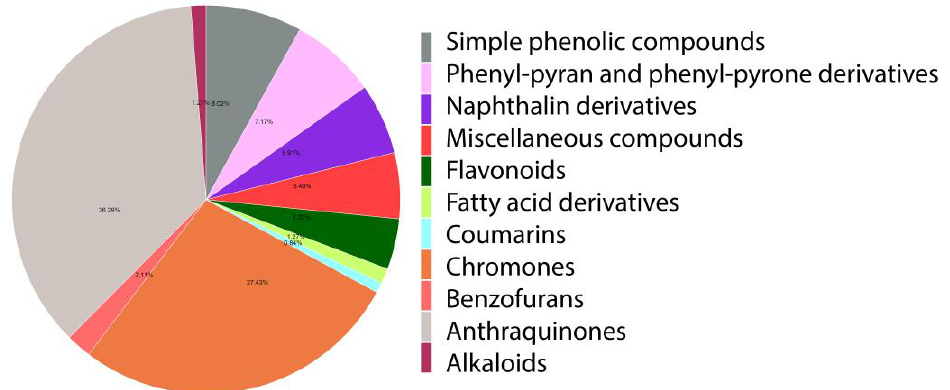
Figure 1. The percentage of different classes of phytochemicals reported from the genus Aloe . An- thraquinones 36.3%, chromones 27.4%, coumarin 0.8%, flavonoids 4.2%, simple phenolic compounds 8%, phenyl pyran and phenyl pyrone derivatives 7%, benzofurans 2%, naphthalene derivatives 5.9%, alkaloids 1.2%, fatty acid derivatives 1.2% and miscellaneous compounds 5.5%.